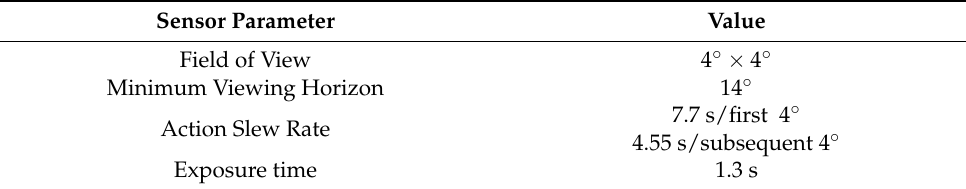
Table 1. Parameters of Optical